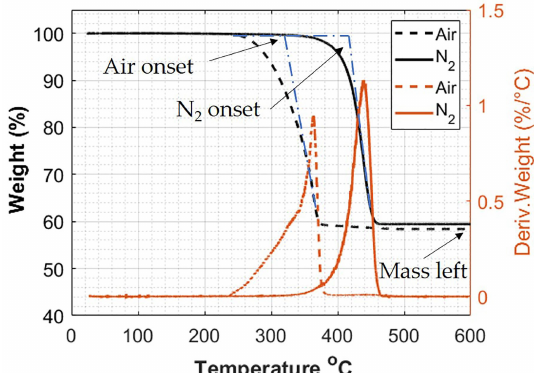
Figure 4. Thermogravimetric Analysis comparison showing the decomposition of glass filled polypropylene in Air and N 2